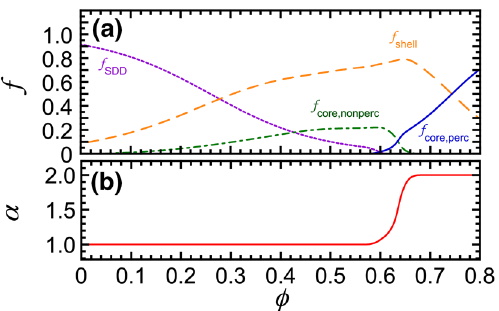
Figure 5. Droplet volume-fraction dependence of: ( a ) component relative volume-fractions, f , determined from Fig. 4a using the E-DCSN model (line types and colors: same as Fig. 4a), and ( b ) dimensionless effective DWS probe-size factor (see text), α , obtained from core components in part (a), which ranges from 1 (single-droplet probe) to 2 (LDC probe).